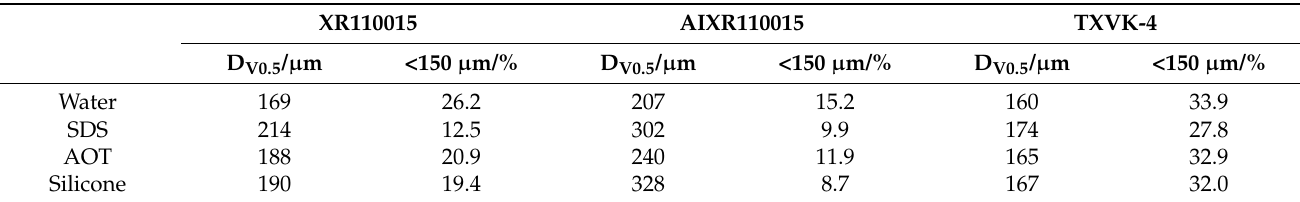
Table 4. D V0.5 and %<150 µ m of the droplet size at different